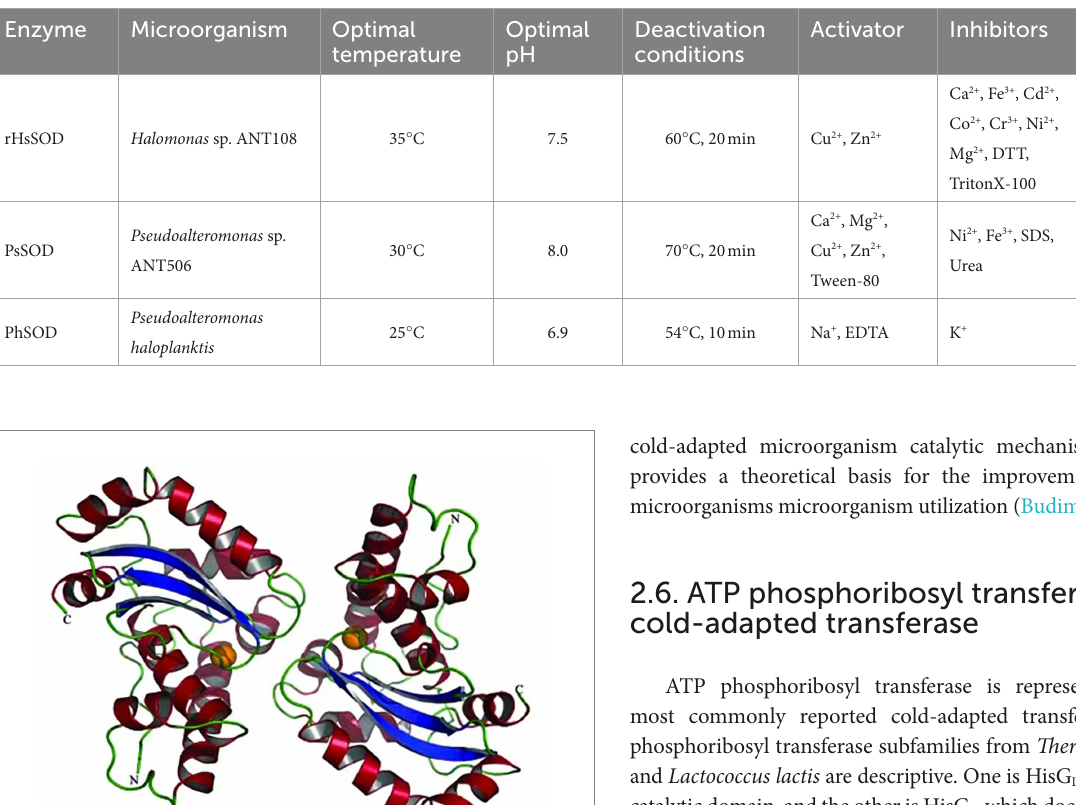
TABLE 2 Cold-adapted superoxide dismutases from various microorganisms and associated characteristics.